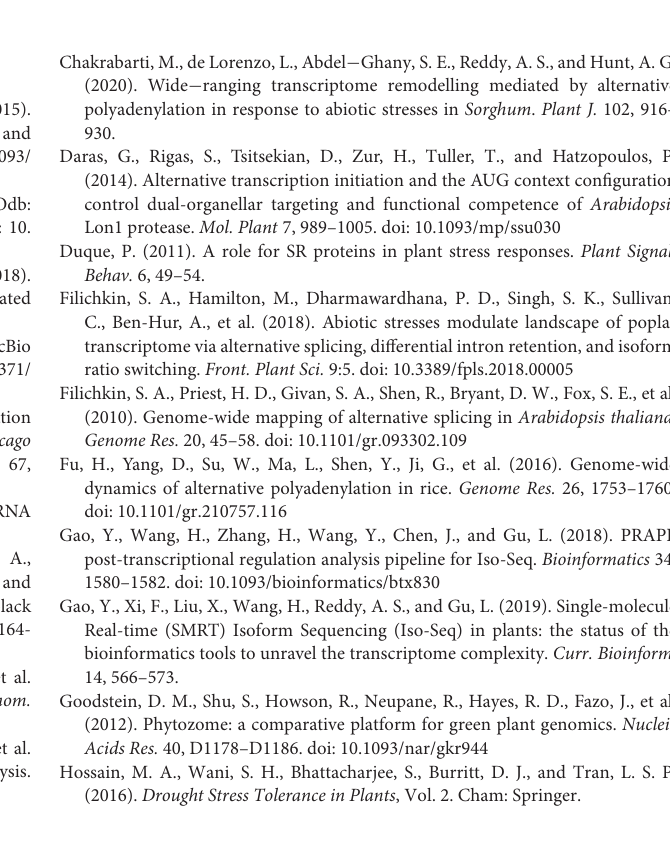
gene. Each AS event contains the information of location and type. Supplementary Table 6 | Differential alternative splicing in stem-differentiating xylem. The first column is the locus name, and the second column is the location information of the